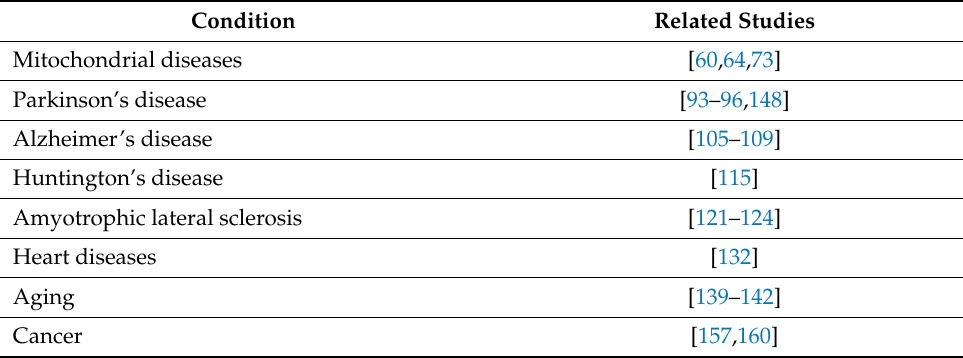
Table 1. Summary of UPR mt -related conditions and